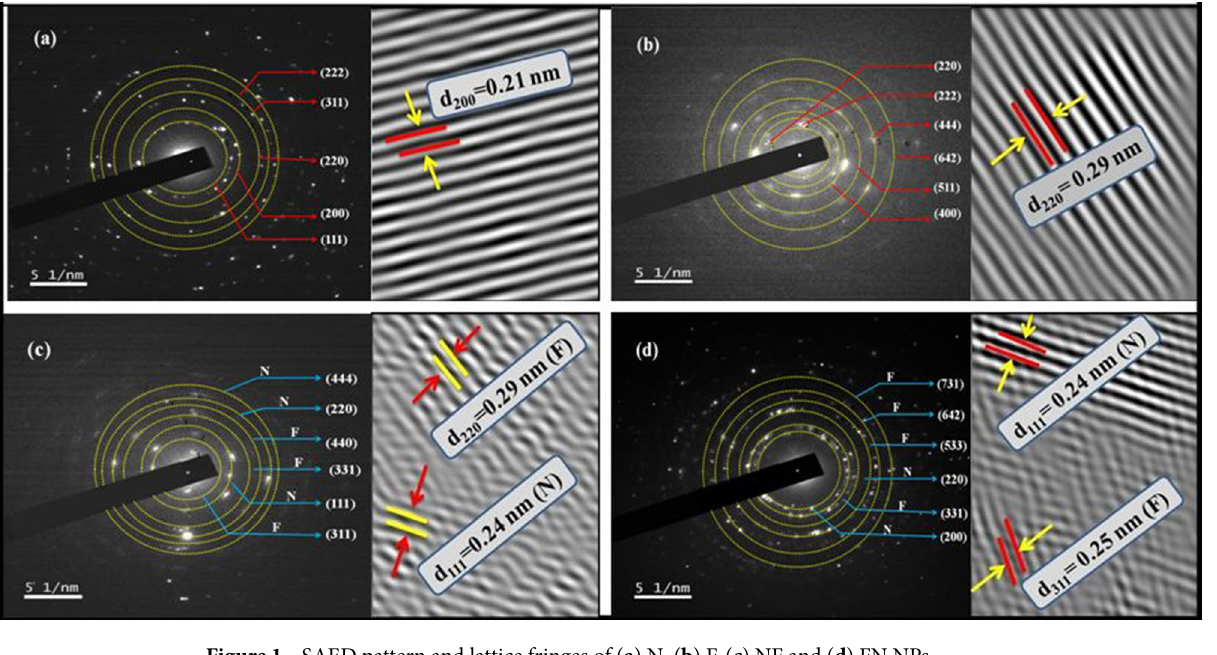
Figure 1. SAED pattern and lattice fringes of ( a ) N, ( b ) F, ( c ) NF and ( d ) FN NPs.